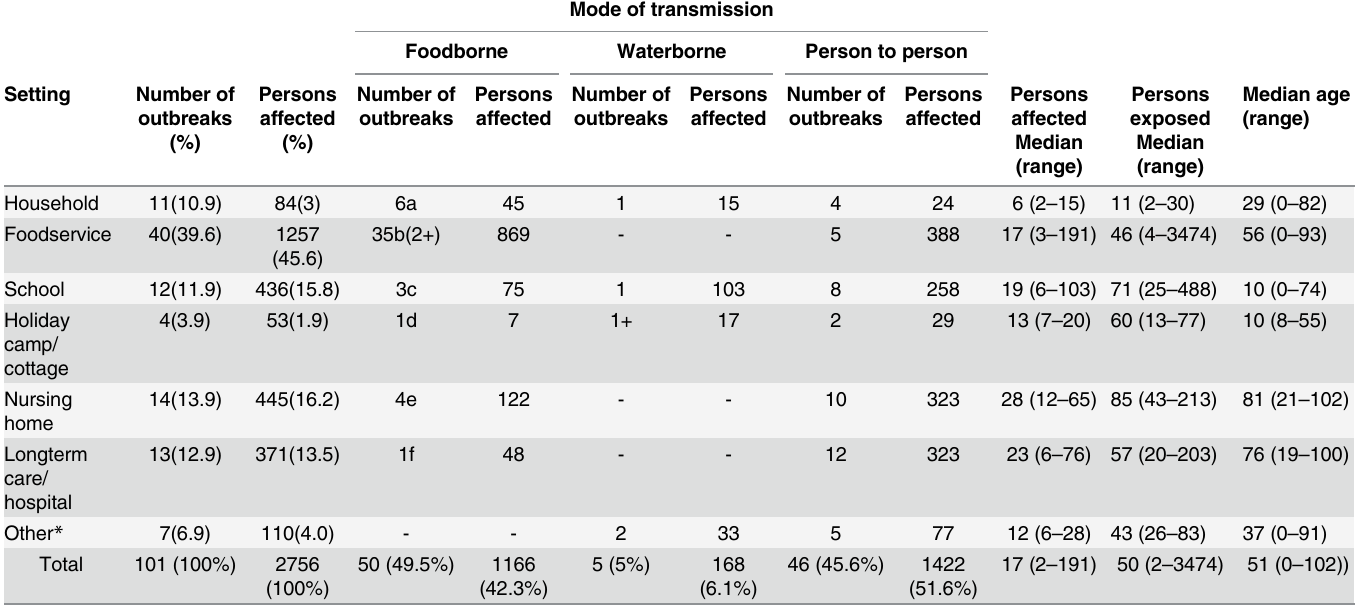
Table 1. Distribution of outbreaks according to setting of occurrence and mode transmission. Catalonia 2010 – 2011.